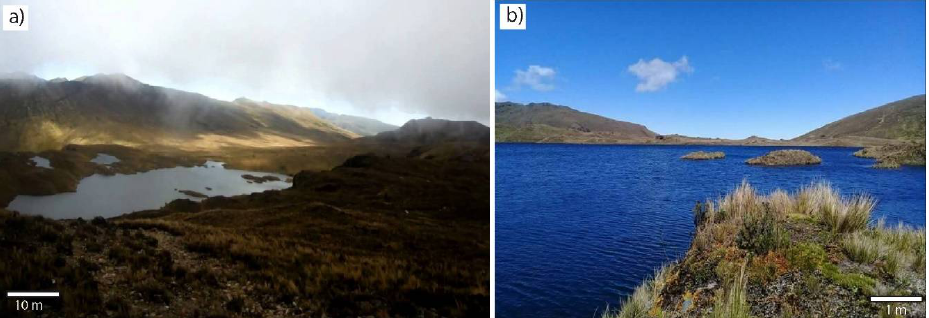
Figure 5. Example of geosite (e.g., Laguna de Chinchilla) inventoried in the study area. ( a ) Panoramic view [37], ( b ) detailed view.